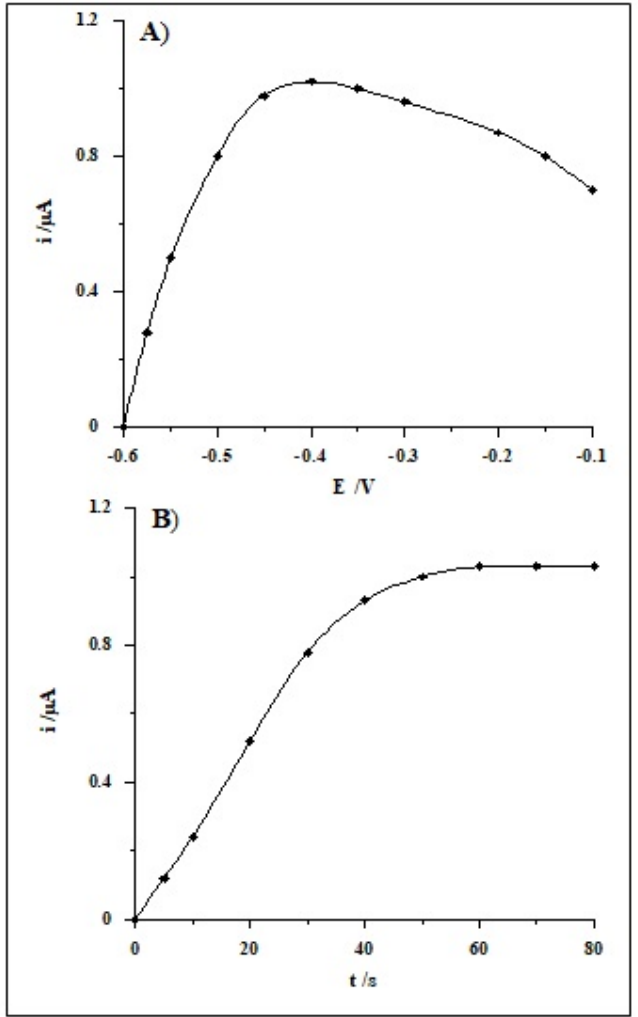
Figure 4. The impact of second accumulation potential ( A ) and its time ( B ) on the voltammetric signal of Se(IV). Steady concentration: 1 × 10 − 7 mol L − 1 Se(IV), 0.1 mol L − 1 acetic acid, 1.9 × 10 − 5 mol L − 1 Bi(III).